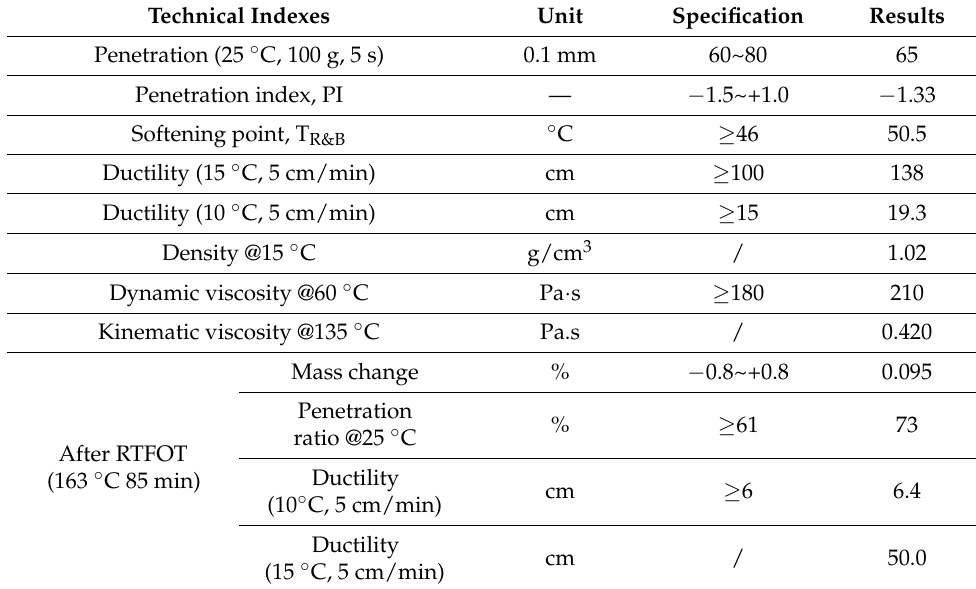
Table 1. Technical indices for AH-70 Petroleum asphalt